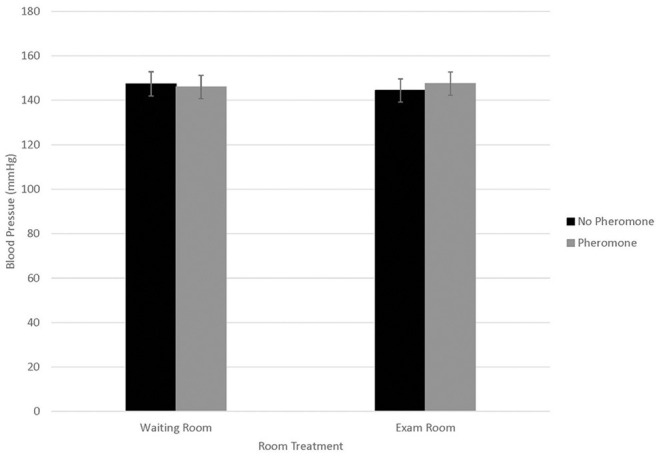
LSMean (±SE) feline blood pressure (mmHg) as assessed using Doppler1 at a veterinary clinic. Over four visits, 39 cats2 were randomly assigned to one of four possible treatment combinations, (WR+/FFP+, WR+/FFP–, WR–/FFP+, WR–/FFP–)3 which were experienced for 10-min prior to the acclimation period and blood pressure measurements. 1Parks Doppler Flow Detector Model Number 811-B with cuff sizes 2–4 cm was used to measure blood pressure. The tail base the primary site, but the rear leg was used when tails were too short or tail manipulation was not tolerated by the cat. The site chosen for each cat was used across all four visits. Hair was clipped on the first visit to facilitate identification of the pulse prior to placement of the Doppler probe, and was re-clipped as needed during subsequent visits. 2All enrolled cats were mature, healthy, and either spayed or neutered. 3WR+: owners and their cats stayed in the waiting room lobby at veterinary clinic for 10 min prior to being taken into the exam room for blood pressure measurements; WR–: owners and their cats were immediately taken into the exam room where they waited for 10 min prior to blood pressure measurements; FFP+: a clean towel was sprayed with feline facial pheromone and placed in their carriers during the 10 min acclimation period; FFP–: no feline facial pheromone was provided.